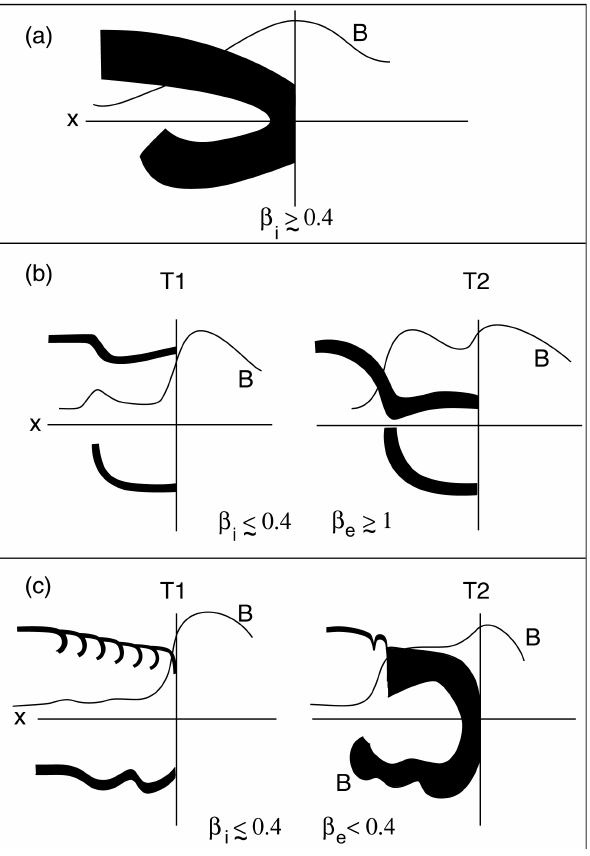
Fig. 12. Schematic of the magnetic field profile and of the ion phase space distribution at a medium Mach number nondispersive quasi- perpendicular shock for various ion and electron beta